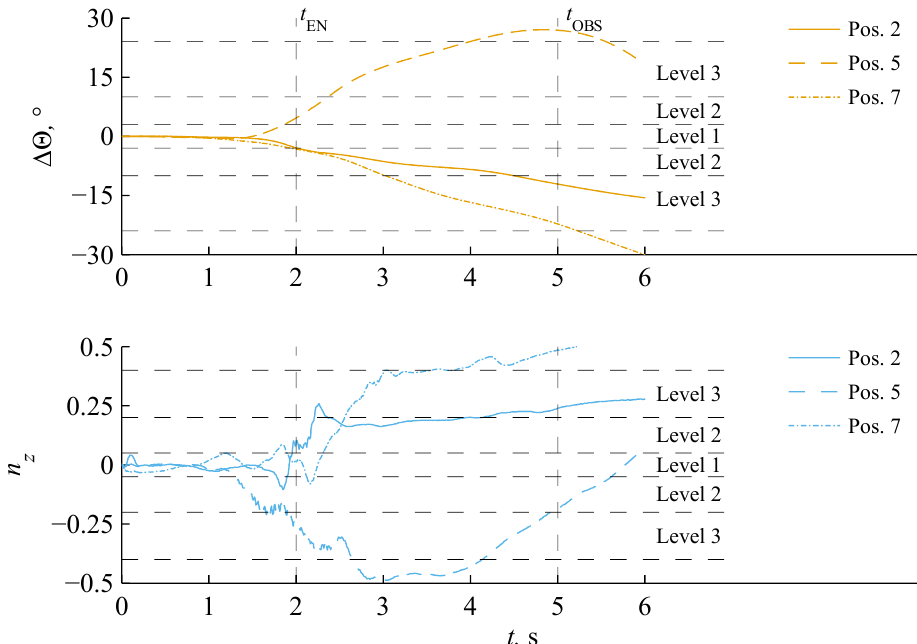
Figure 19. Comparison of pitch the attitude change ∆Θ and the load factor n z for the non-piloted simulation of C1 between position 2, position 5 and position 7 with limits of ADS-33 offline criteria (flight direction